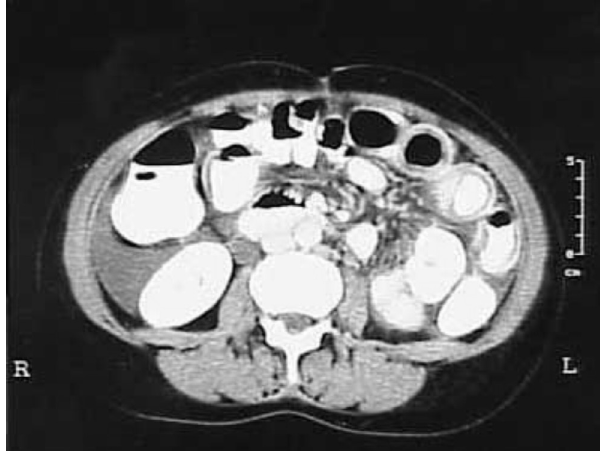
Figure 1 - Abdominal computerized tomography showing dilated bowel, focal or diffuse bowel wall thickening, and abnormal bowel wall enhance- ment (a double halo or target sign).